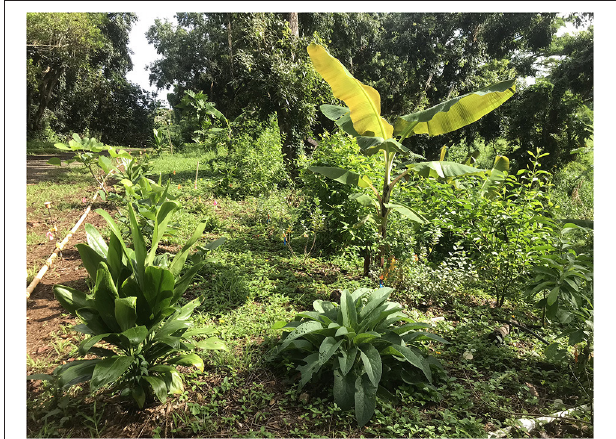
FIGURE 1 | Practitioners in Hawai‘i integrate trees and shrubs with other plants and animals in agroforestry systems ranging from cacao and windbreak systems, to multi-story forests including a range of native and non-native plants for multiple products, to silvopasture with native trees and cattle. Pictured here is an example of a multi-story agroforestry plot in the establishment phase at K ¯ ako‘o ‘ ¯ Oiwi, He‘eia, O‘ahu. Key visible plants include a native, culturally important tree, wiliwili ( Erythrina sandwicensis ); Polynesian introductions ti ( Cordyline fruticosa ) and mai‘a iholena lele ( Musa sp.; banana); and an introduced medicinal plant, comfrey ( Symphytum officinale